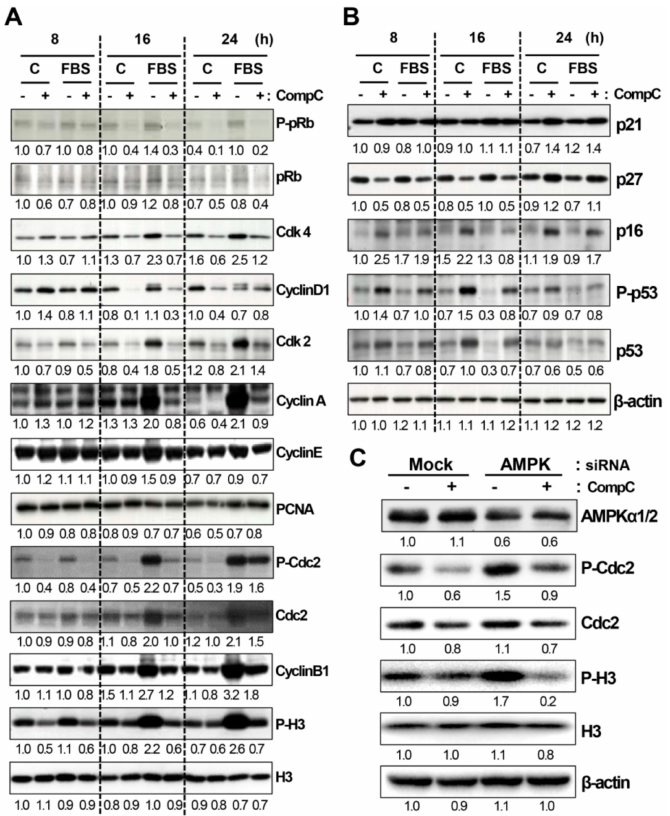
Figure 2. CompC altered the expression and phosphorylation of cell cycle regulatory proteins in an AMP-activated protein kinase (AMPK)-independent manner. ( A , B ) Quiescent cells were stimulated with 10% fetal bovine serum (FBS) for the indicated times (8, 16, and 24 h) in the presence of vehicle ( − ) or 10 µ M CompC ( + ). Cell lysates were analyzed by western blot analysis using antibodies against total and phosphorylated pRb (P-pRb), Cdks, cyclins, and histone H3 ( A ), Cdk inhibitors ( B ), and β -actin as an internal control. The band density of β -actin was used as a normalization control for densitometry analysis of blots in ( A , B ). ( C ) B16-F1 cells were transfected with mock or AMPK α 1 / 2 siRNA for 48 h and then stimulated with 10% FBS in the presence of vehicle ( − ) or 10 µ M CompC ( + ) for 16 h. Cell lysates were analyzed by western blot analysis using antibodies against AMPK α 1 / 2, total and phosphorylated Cdc2 and histone